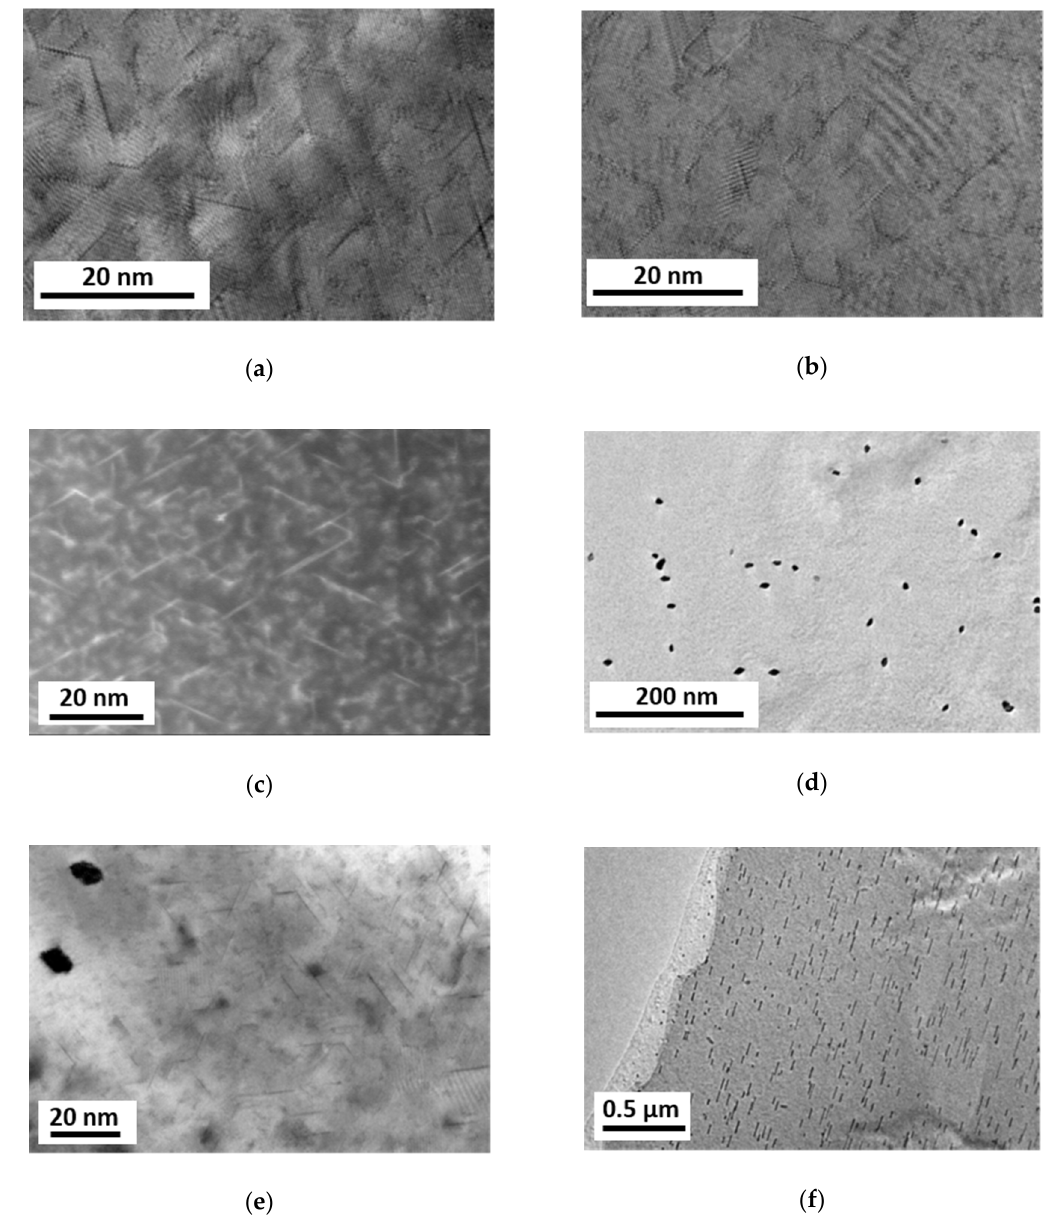
Figure 8. Micrographs revealing precipitate structures in Mg5Zn samples: ( a ) bright-field transmission electron microscopy (TEM) after HPT-processing; ( b ) bright-field TEM and ( c ) HAADF STEM after HPT and following heat treatment at 100 °C for 24 h; ( d – f ) bright-field TEM after HPT and following heat treatment at 150 °C for 2 h. In the micrographs ( a – e ), the observation is close to <0001>, while in ( f ) it is close to <10 1(cid:3364) 0>.